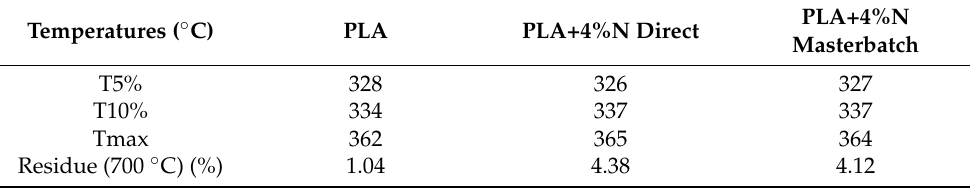
Table 2. Degradation temperatures for PLA+4%N nanocomposites and neat